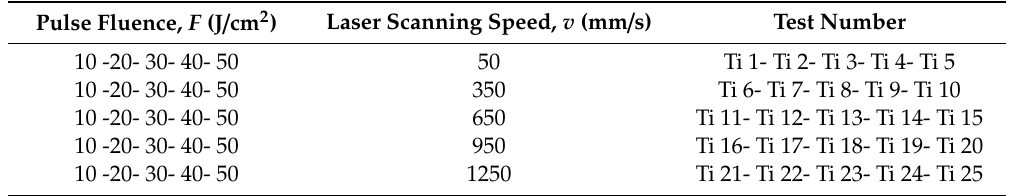
Table 1. Laser parameters for Titanium